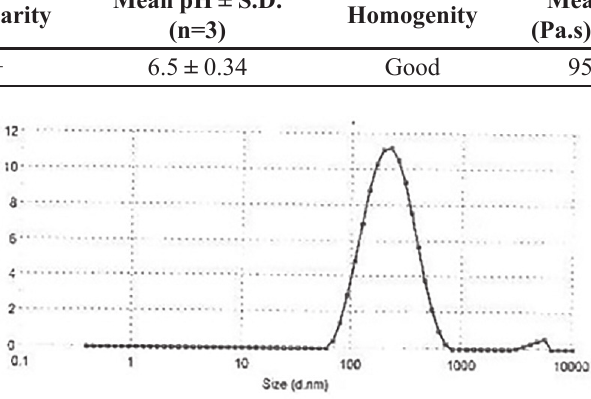
TABLE IX - Evaluation of ERY loaded SLN gel Clarity